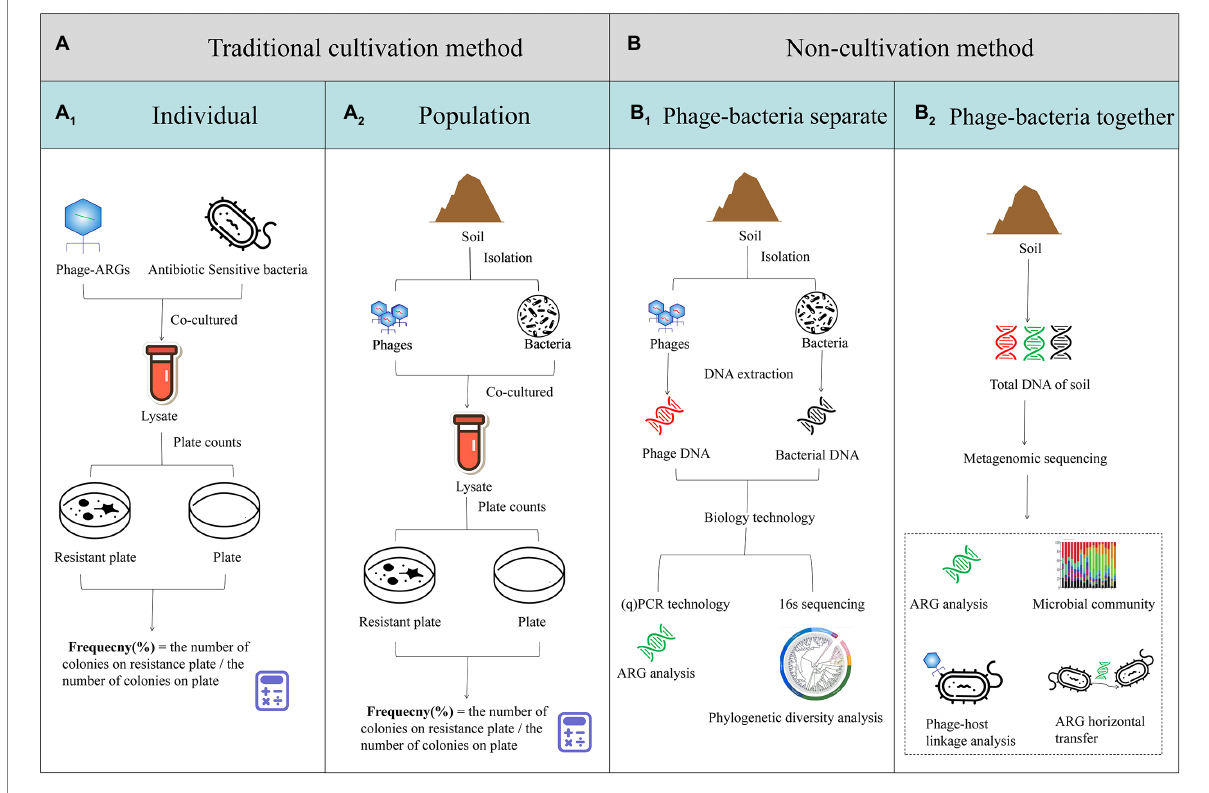
FIGURE 2 Research methods for phage-mediated transduction of antibiotic resistant genes (ARGs) in vitro. (A) Traditional cultivation methods using an individual phage containing ARGs co-cultured with antibiotic-sensitive bacteria (A 1 ) or a soil sample from which the phage and bacteria populations were isolated and co-cultured (A 2 ) . (B) Non-cultivation methods using soil samples from which the phage and bacteria populations are isolated using centrifugal filtration, their DNA is extracted and ARGs and phylogenetic diversity is analyzed through PCR or 16 s sequencing, respectively (B 1 ) , or the total DNA of the soil is extracted analyzed through metagenomic sequencing (B 2 )